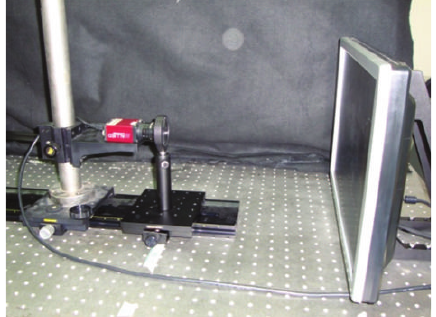
Figure 3: Camera-collimator-monitor on the optical bench.